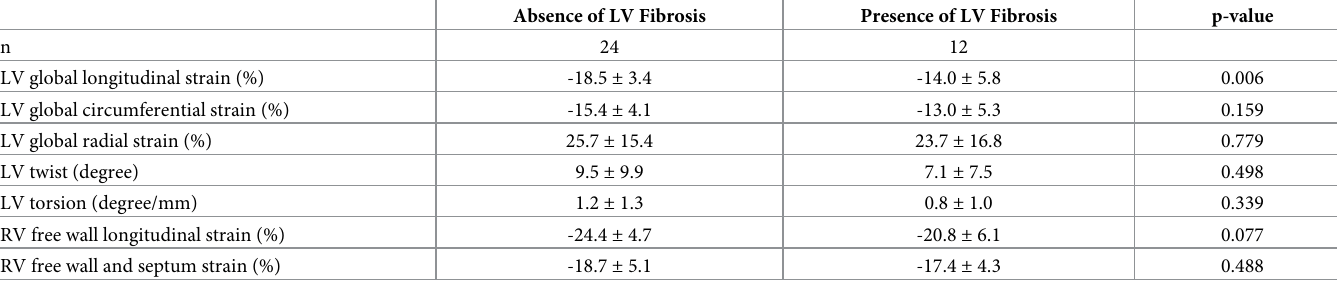
Table 4. Relationship of echocardiographic parameters of LV and RV ventricular mechanics and LV fibrosis in patients with Chagas disease (IFCD+CCC).